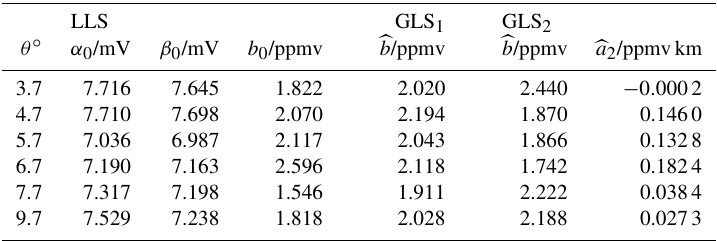
Table 2. For each elevation angle θ (column 1), estimates (α 0 , β 0 , b 0 ) provided by the two-step LLS approach (LLS, columns 2–4), estimate b b of b provided by the GLS approach with α = α 0 and β = β 0 for data with indices I 2 = { m e = 100, ..., m HGH = 500 } (GLS 1 , column 5), and estimates ( b b , b a 2 ) of (b,a 2 ) provided by the GLS approach with α = α 0 and β = β 0 for data with indices I 1 ∪ I 2 with I 1 = { m LOW = 30, ..., m s = 50 } (GLS 2 , columns 6–7). LLS GLS 1 GLS 2 θ ◦ α 0 /mV β 0 /mV b 0 /ppmv b b